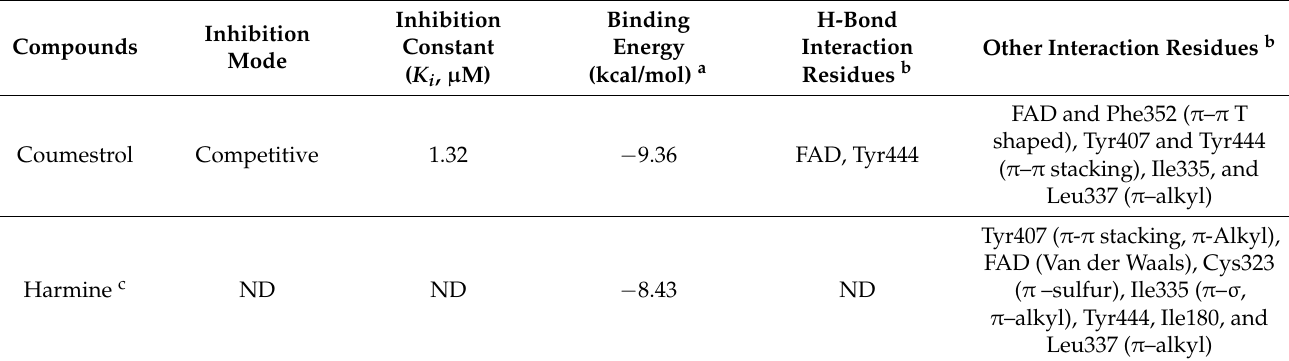
Table 3. Enzyme kinetic property and binding mode of coumestrol on MAO-A.